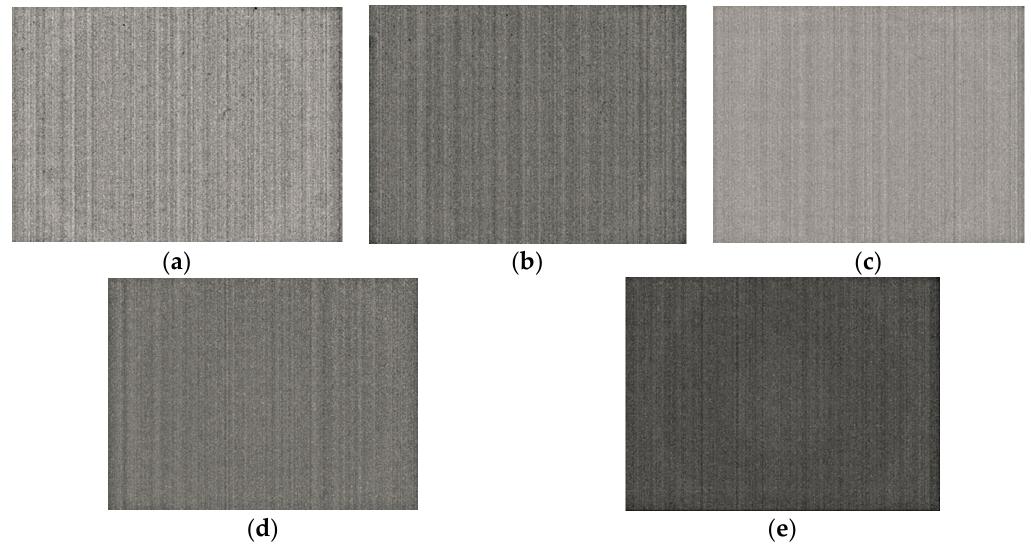
Figure 14. Response noise of band images corrected for dark current and vignetting effect: ( a ) Band1 image; ( b ) Band2 image; ( c ) Band3 image; ( d ) Band4 image; ( e ) Band5 image.